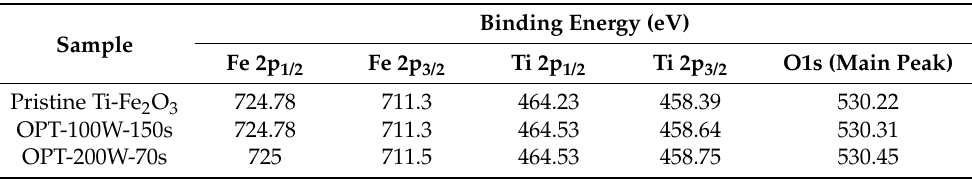
Table 2. The listed binding energy values of Fe, Ti, and O elements in X-ray photoelectron spec- troscopy (XPS) spectra for the films of the pristine Ti-Fe 2 O 3 , OPT-100W-150s, and OPT-200W-70s.